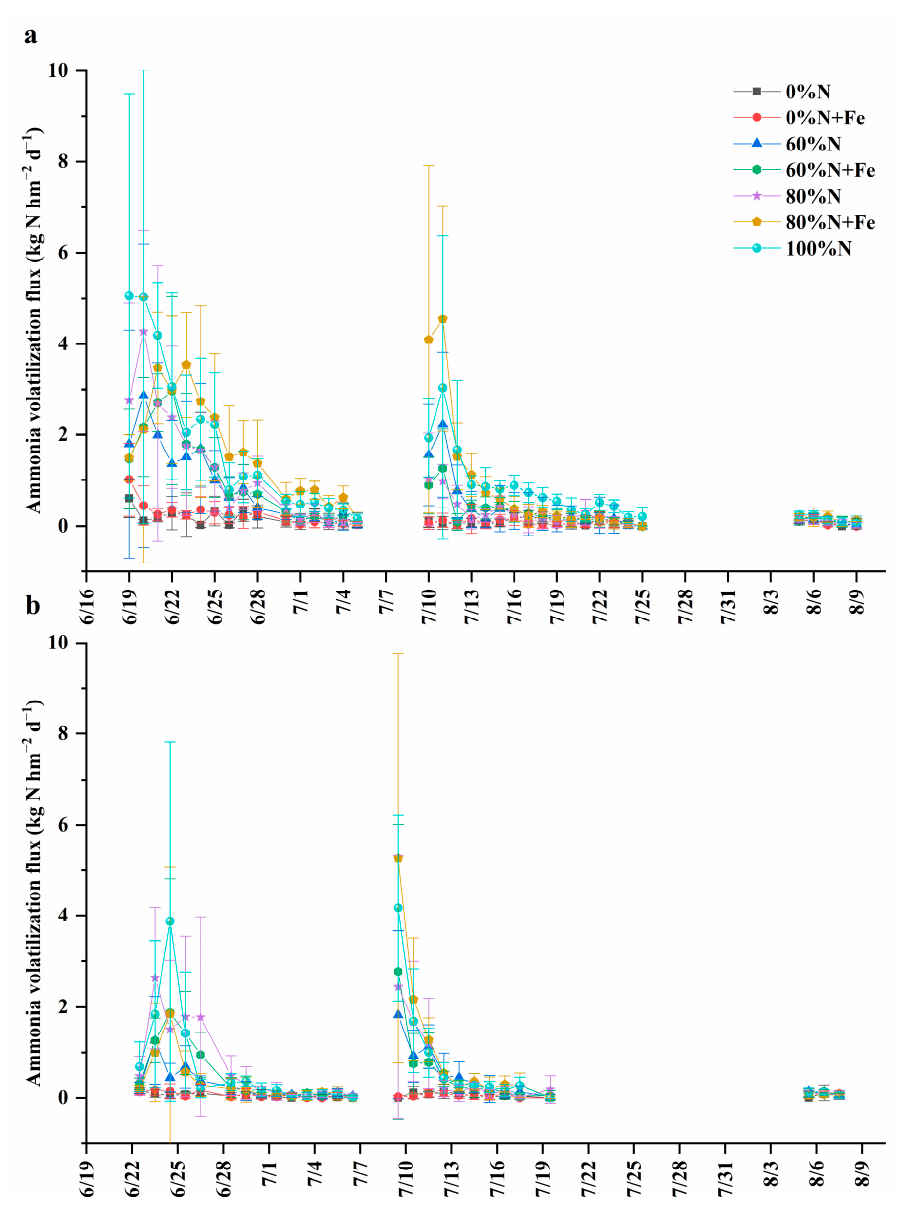
Figure 3. Ammonia volatilization flux from a paddy field under various nitrogen fertilization rates with or without iron amendment in 2019 ( a ) and 2020 ( b ). Conventional N fertilization rate (315 kg N hm − 2 season − 1 ) for rice in lower Yangtze River Delta is 100%N. Fe was applied at 5000 kg hm − 2 as iron powder (>99% purity) when the field experiment was